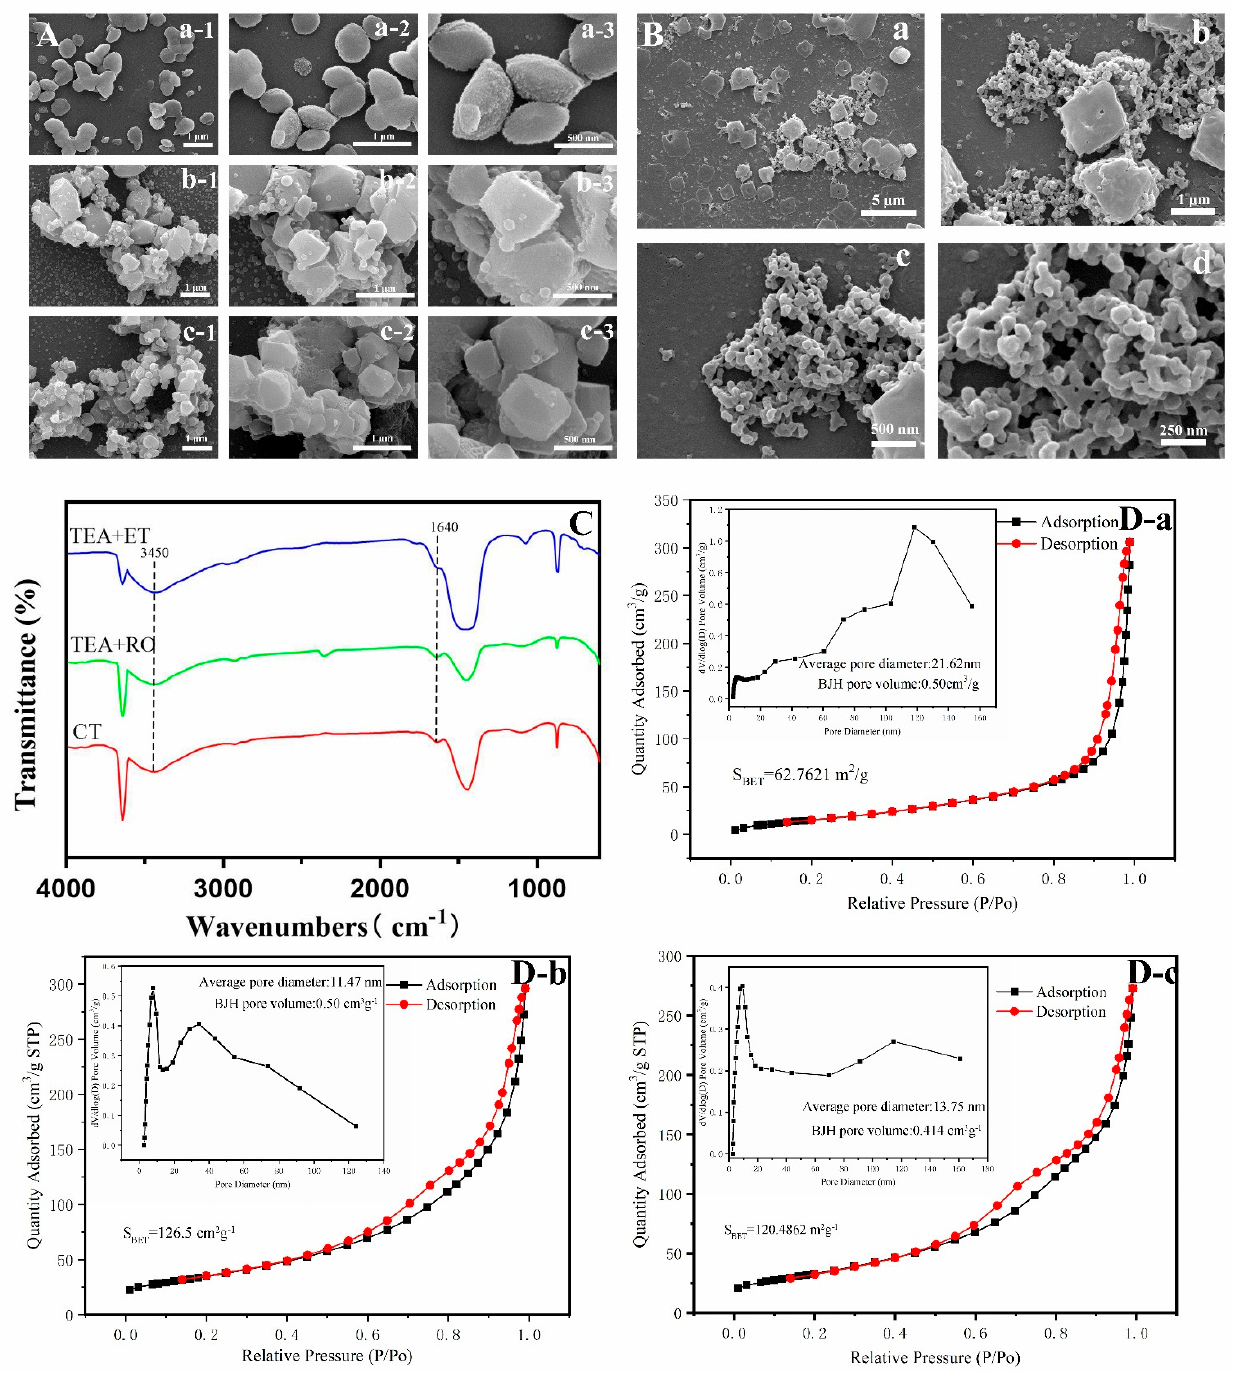
Figure 6. ( A ) SEM images of intermediate product (Ca(OH) 2 ) of ( A - a ) TEA+ET group, ( A - b ) TEA+RO group, and ( A - c ) CT group. ( B ) SEM images of the process of dissolution and reprecipitation in TEA+ET group. The change of the reaction between Ca(OH) 2 and H 3 PO 4 within 30 min. ( C ) FTIR spectra of Ca(OH) 2 . ( D ) Nitrogen adsorption/desorption isotherms and pore size distribution of ( D - a ) TEA+ET group, ( D - b ) TEA+RO group, and ( D - c ) CT group.